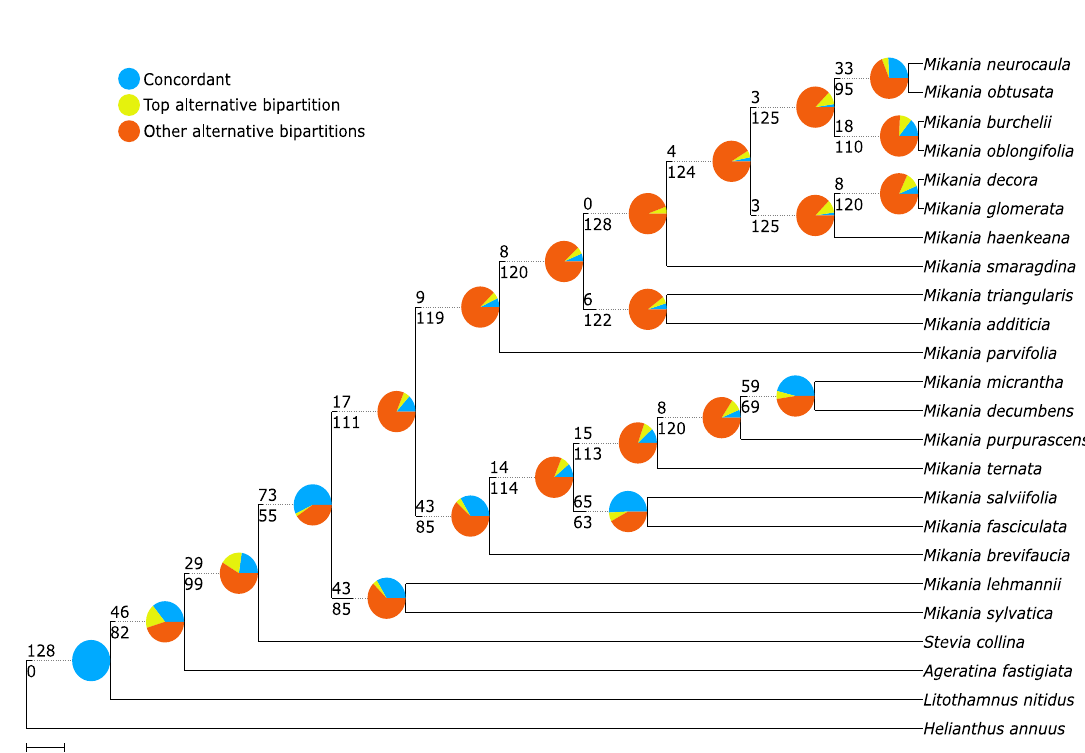
Figure 4. Multidimensional scaling of adjusted Robinson-Foulds values calculated from the pairwise comparison of all rooted trees. Coding: analyses conducted only with the coding regions (CDS). Non-coding: analyses conducted with non-coding regions (intergenic regions and introns). Total: whole plastome sequence with one IR removed.